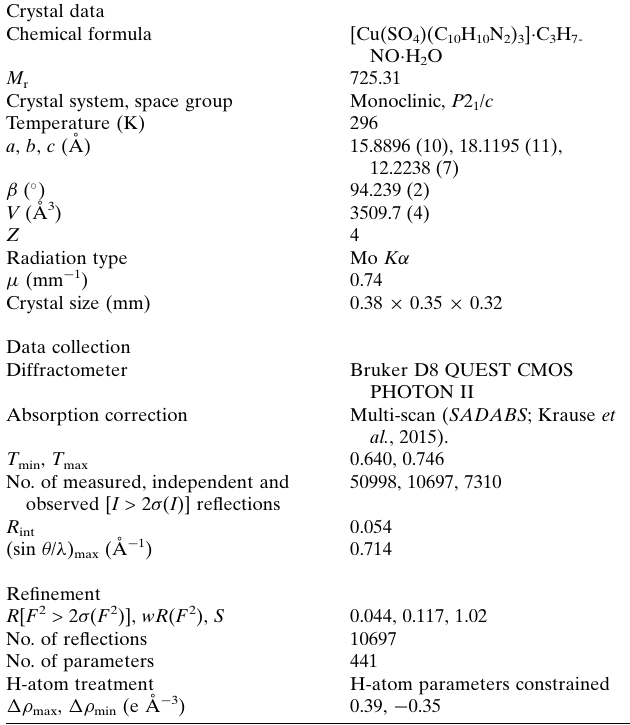
Table 2 Experimental details. Crystal data Chemical